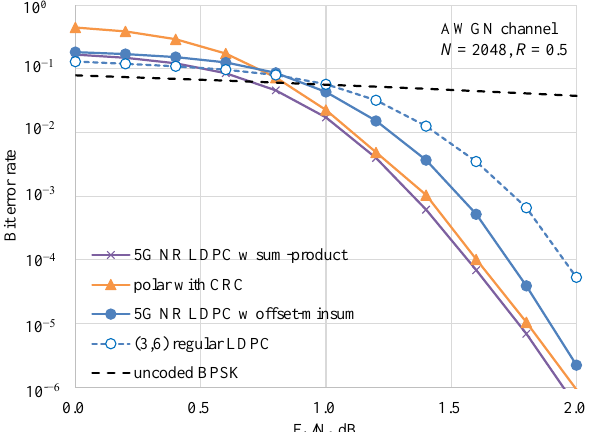
Figure 10. Performance comparison of polar code with 5G NR LDPC code in AWGN channel.